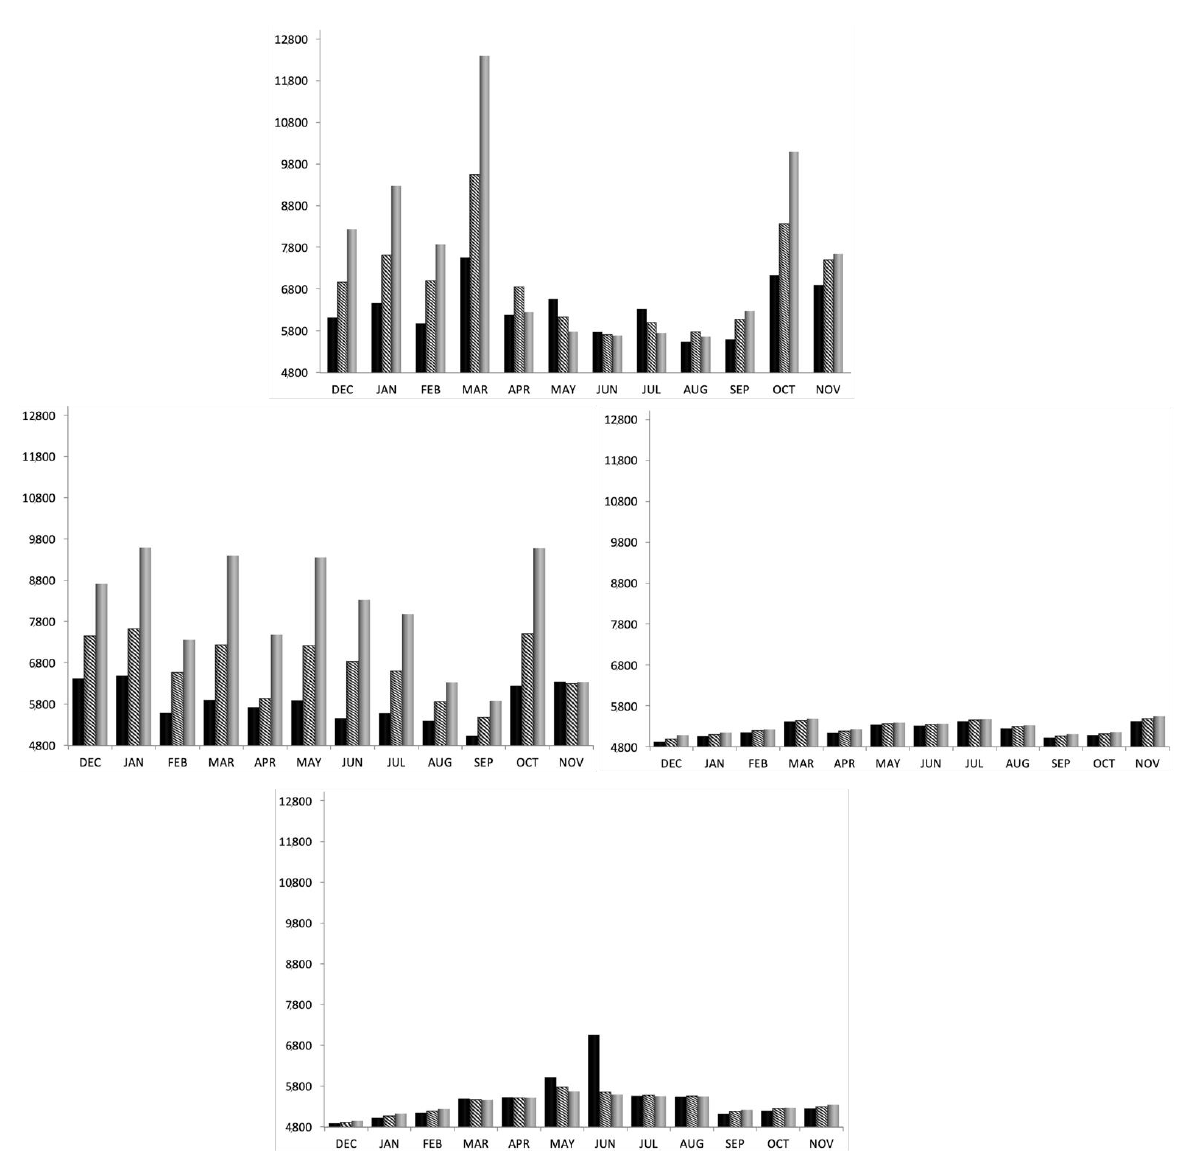
Figure 3. CCT (K) measured depending on the season (from December 2018 to November 2019); orientation of north ( top ), east ( right ), south ( down ), and west ( left ); and elevation from the horizontal level of 15° (black), 30° (striped), and 45° (grey).